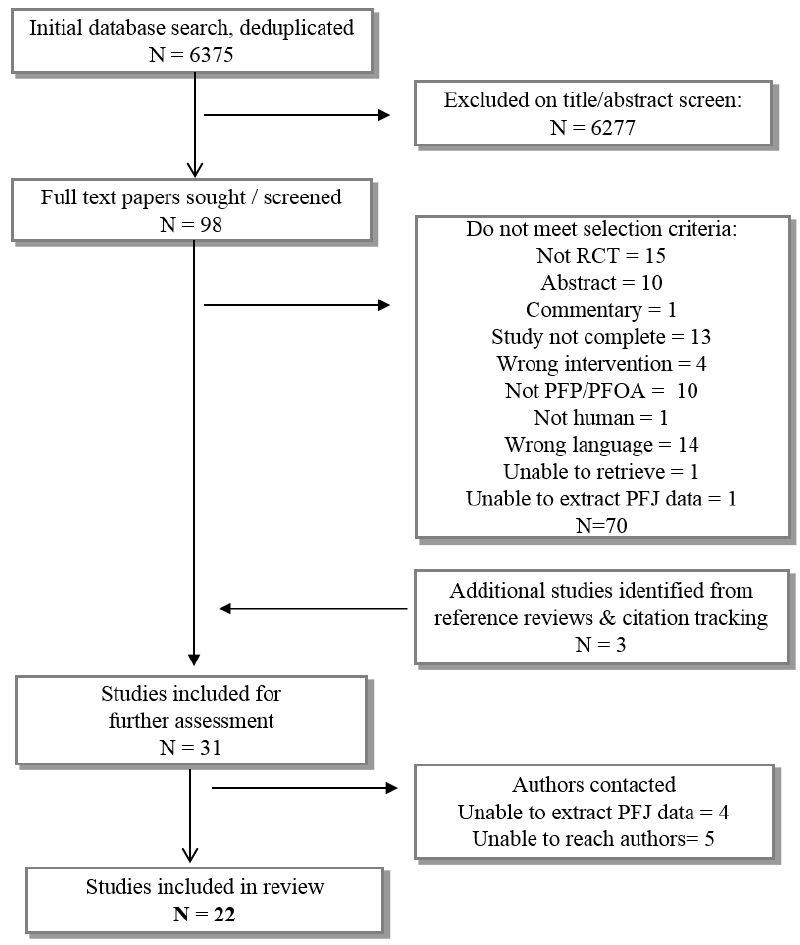
Figure 1. Flow chart of study selection.